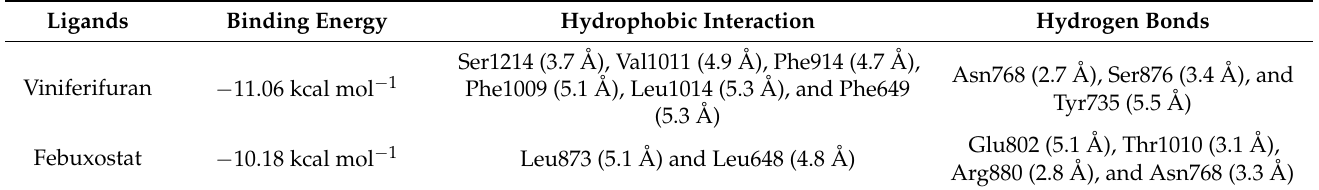
Table 3. The docking results of febuxostat and viniferifuran with 1N5X. Ligands